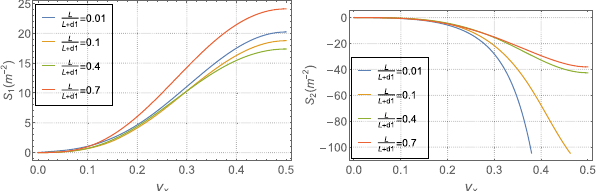
FIG. 9. Sextupoles ’ strengths of mTME cell as a function of horizontal